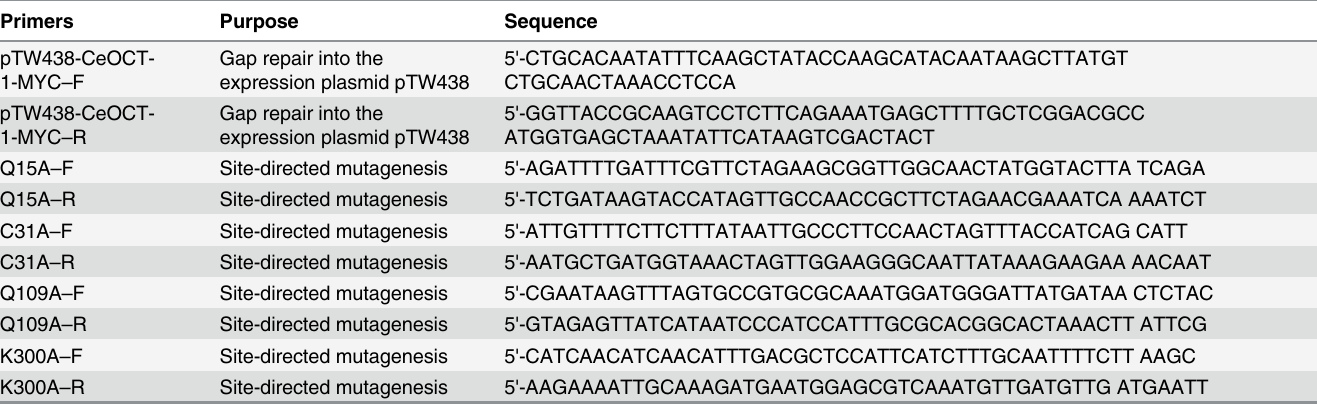
Table 1. Oligonucleotide primers used in this